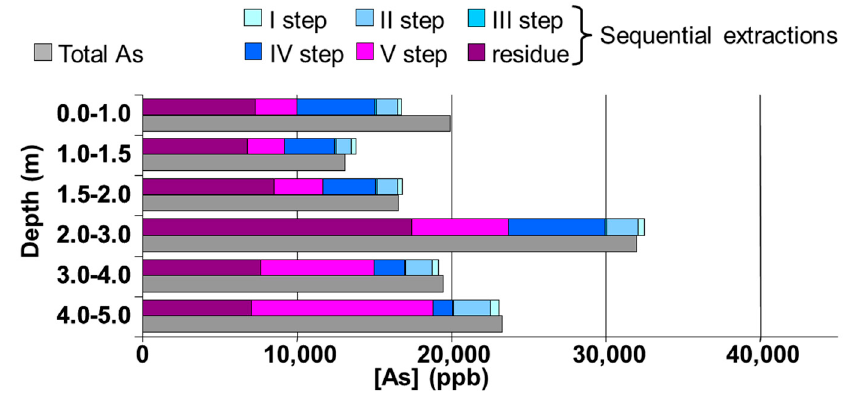
Figure 2. Average values of the six fractions of As resulting from sequential extraction, in the six levels of the five cores of point S53 and its close surroundings.